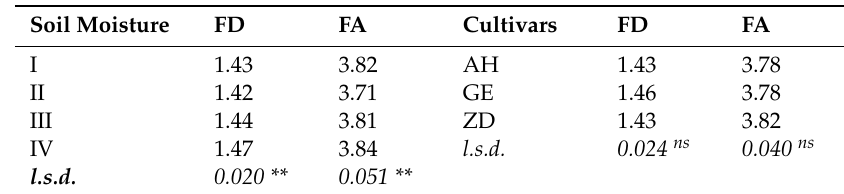
Table 4. Mean fractal dimensions (FD) and fractal abundances (FA) under various soil moisture (See Table 1 for soil moisture abbreviations) and cultivar (AH, GE and ZD) treatments. ** p < 0.01;